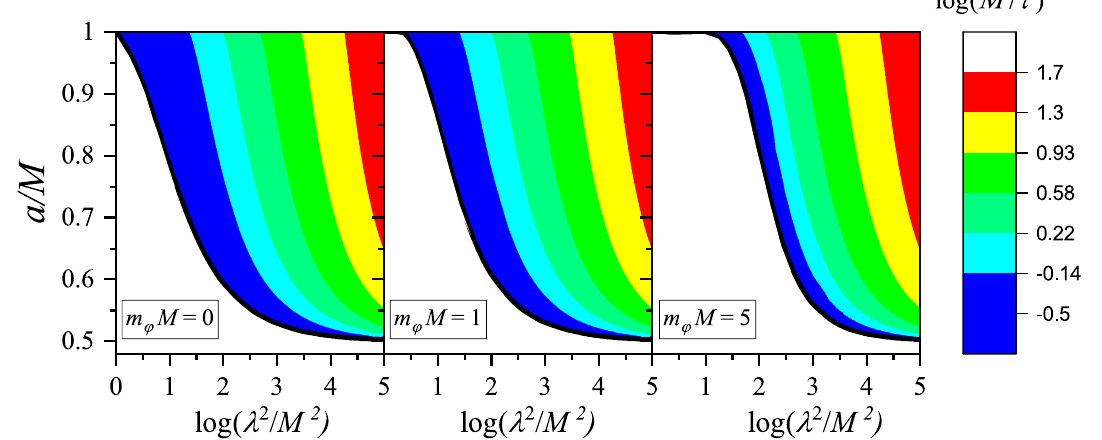
Fig. 2 Contour plots of the growth time of the unstable modes for m = 0 and several values of the scalar field mass – m ϕ M = 0 ( left ), m ϕ M = 1 . 0 ( middle ), and m ϕ M = 5 . 0 ( right ). In addition, the thresh-